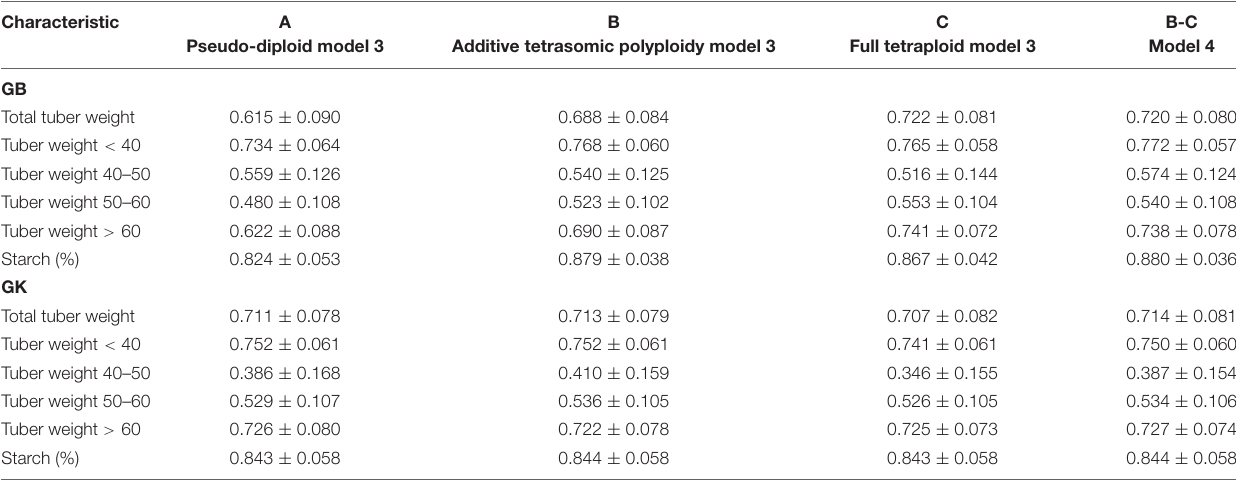
TABLE 5 | Multi-environment, genomic best linear unbiased predictor (GBLUP) (GB) and Gaussian-kernel (GK) prediction accuracy ( ± standard deviation) for potato tuber characteristics considering pseudo-diploid (A) (model 3), additive tetrasomic polyploid (B) (model 3), full tetraploid (C) (model 3), and B-C (model 4) with fourfold partitions of 10 random samples each in Helgegården 2020 ( N = 169).